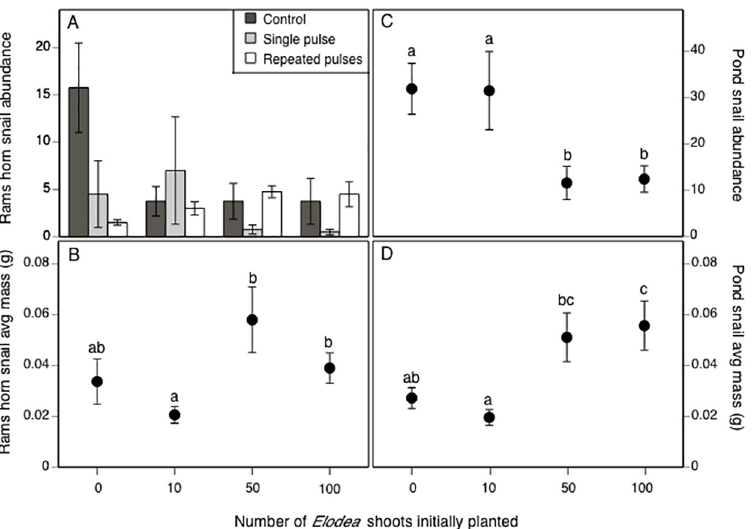
Fig 6. The impacts of A) the insecticide-by- Elodea treatment interaction on rams horn snail abundance, and Elodea treatment effects on B) rams horn snail average mass, C) pond snail abundance, and D) pond snail average mass. For panels B-D, different lowercase letters represent significant differences between Elodea -treatments ( α = 0.05). Snails were sampled on day 68 using traps baited with alfalfa pellets. All data are means ± 1 SE. p (cid:1) 0.116). In the 10- Elodea treatment, insecticides had no effect on rams horn snail abun- (cid:3) 4.0, p (cid:1) 0.05). In the 50- and 100- Elodea treatments, we detected effects dance (all F 2,9 (cid:1) 4.6, p (cid:3) 0.043); rams horn snail abundance was 75% lower in of insecticides (all F 2,36 single-pulse than in repeated-pulse treatments ( p = 0.039). Controls did not differ from the single- and repeated-pulse treatments (all p (cid:1) 0.127). Rams horn snail average mass was = 2.9, p = 0.052); where average mass was marginally affected by Elodea treatment ( F 3,36 over 1.8 times larger in the 50- and 100- Elodea treatments than in the 10- Elodea treatment (Fig 6B, p (cid:3) 0.026), though there were no other differences between Elodea treatments ( p (cid:1) 0.178).